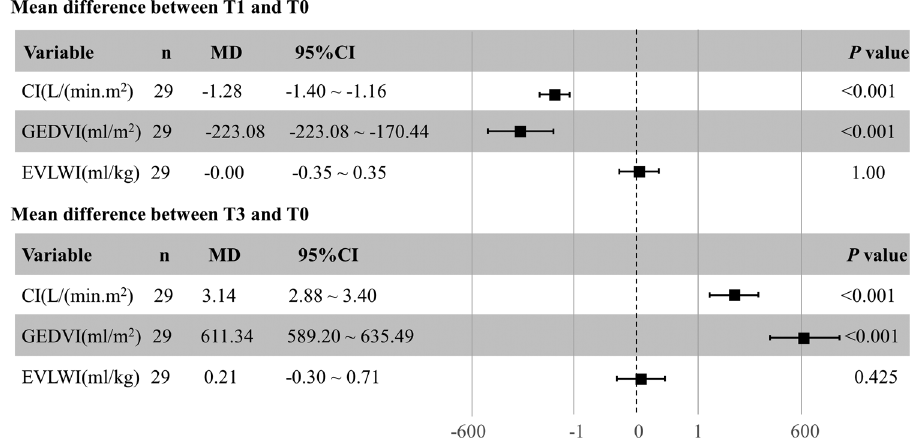
Compared to T0, the asterisk indicates P < 0.01. CI: cardiac index; GEDVI: global end - diastolic volume index; EVLWI: extravascular lung water index; BT: body temperature; HR: heart rate; MAP: mean arterial pressure; CRRT: continual renal replacement therapy; T0: before